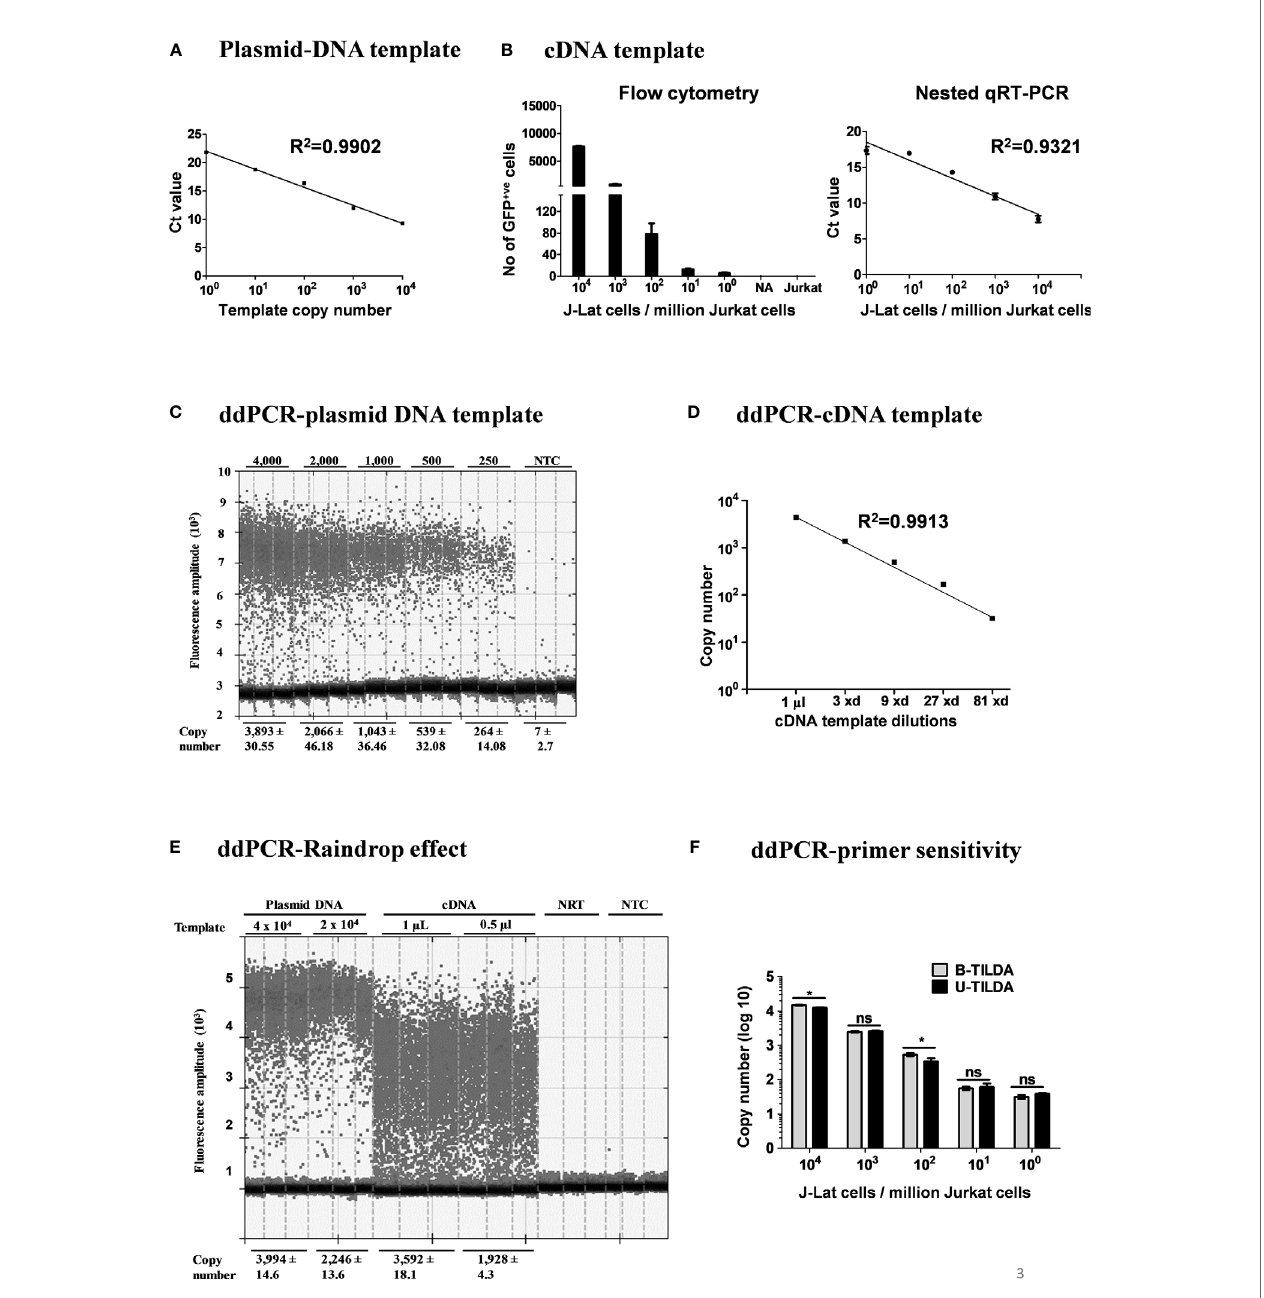
FIGURE 3 | Ampli fi cation ef fi ciency of the new primer-probe set. (A) Standard curve of ampli fi cation using a plasmid DNA, pBSKS-MS1, at a de fi ned copy number (10 4 -10 0 copies). The data are representative of three independent experiments performed in triplicate. Each data point on the graph represents the Mean ± SD of three Ct replicate values. (B) Flow cytometry analysis of J-Lat 8.4 cells pulsed into a background of 10 6 Jurkat cells and then activated (left panel). cDNA of the viral transcripts of the activated cells was used as the template for ampli fi cation. The right panel represents the standard curve of the C t values (Mean ± SD) of three independent assay done in triplicates with inter-assay CV of 5%. (C) ddPCR of serially diluted pBSKS-MS1 plasmid using U-TILDA primers and probe. (D) ddPCR of serially diluted J-Lat cDNA sample prepared as in panel (B) . (E) ddPCR performed using cDNA of the RNA extracted from HEK293T cells transfected with pIndie C1 molecular clone or pBSKS-MS1 as the template. The template copy number is indicated at the top of the lanes. Each assay contained three replicate wells, and each lane represents one well. The dark dots at the bottom of each lane represent the negative droplets with no fl uorescence (no ampli fi cation), and the grey dots above represent the positive droplets. The number of accepted droplets for each well ranges from 14,000-17,000. Copy number was determined using Poisson ’ s calculation. The number of positive droplets is indicated at the bottom of the wells. The data are representative of two independent experiments (Left panel). A standard curve of ampli fi cation is presented (Right panel). NRT, No reverse transcriptase control; NTC, No template control. (F) The primer-probe sets of B- and U- TILDA formats have been compared in a ddPCR using de fi ned numbers of J-Lat cells serially diluted into one million Jurkat cells before cell activation as in panel (B) A Paired t -test was performed to compare the data. (*p < 0.05, ns, not signi fi